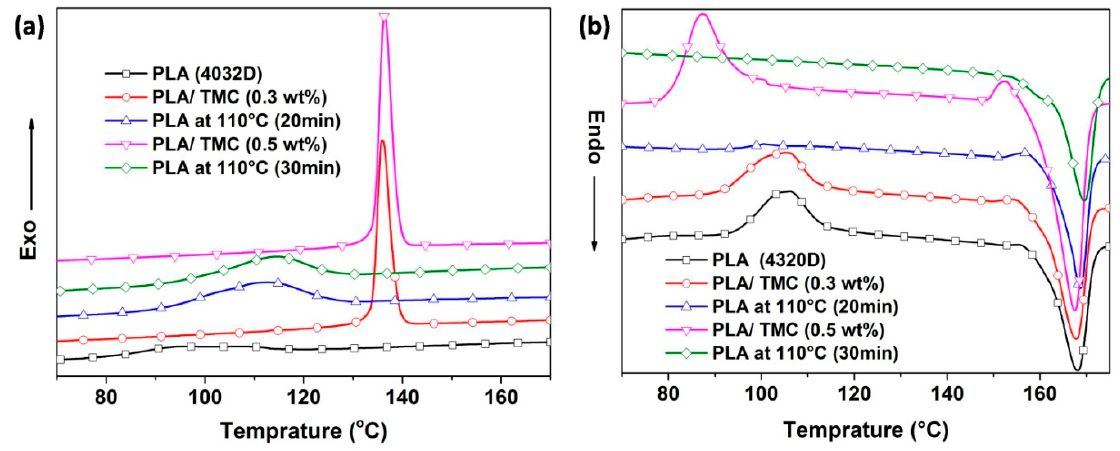
Figure 3. DSC curve of neat PLA, PLA / TMC (0.3 wt% and 0.5 wt%) composites and PLA (subjected to heat treatment at 110 °C for 20 and 30 min). ( a ) Crystallization and ( b ) melting curves.